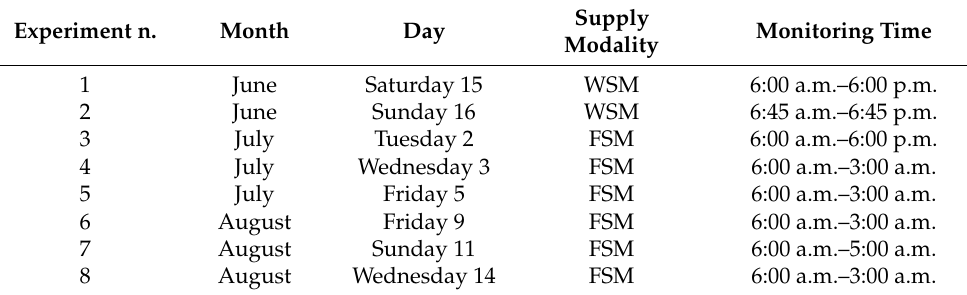
Table 2. Summary of the experimental conditions for the 8 days of experiments. Experiment